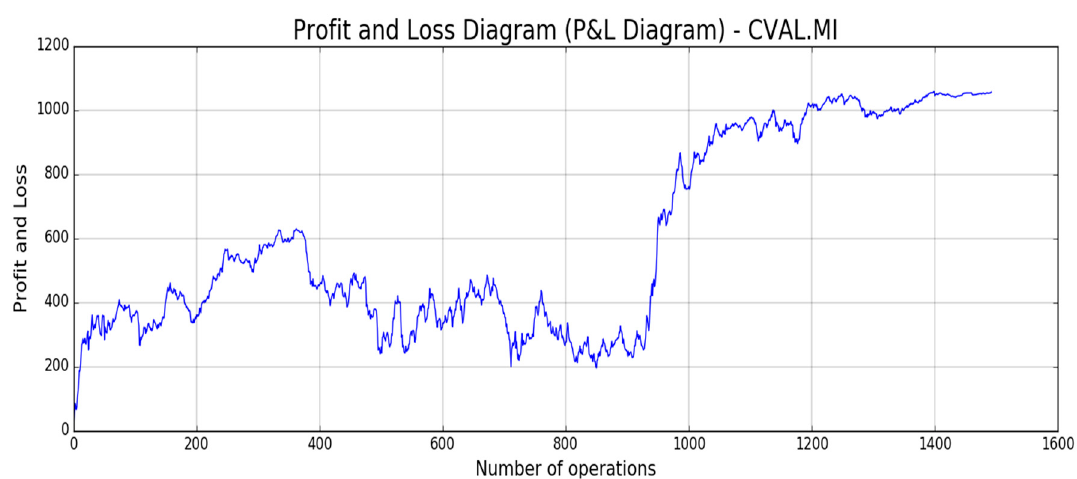
Figure 19. CVAL.MI Profit and Loss Diagram.